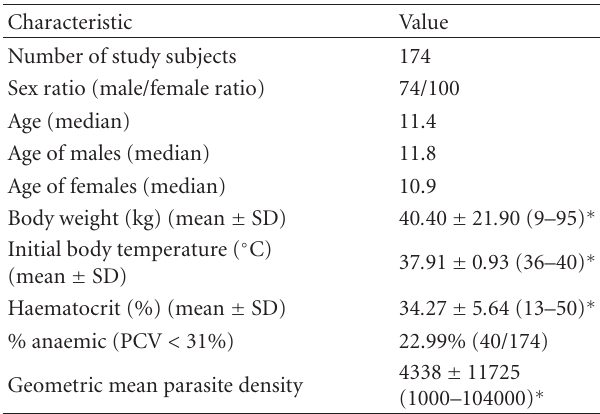
Table 1: Baseline characteristics of patients attending Cameroon Christian Medical Foundation (CAMEF) during the in vivo study, 2007-2008.